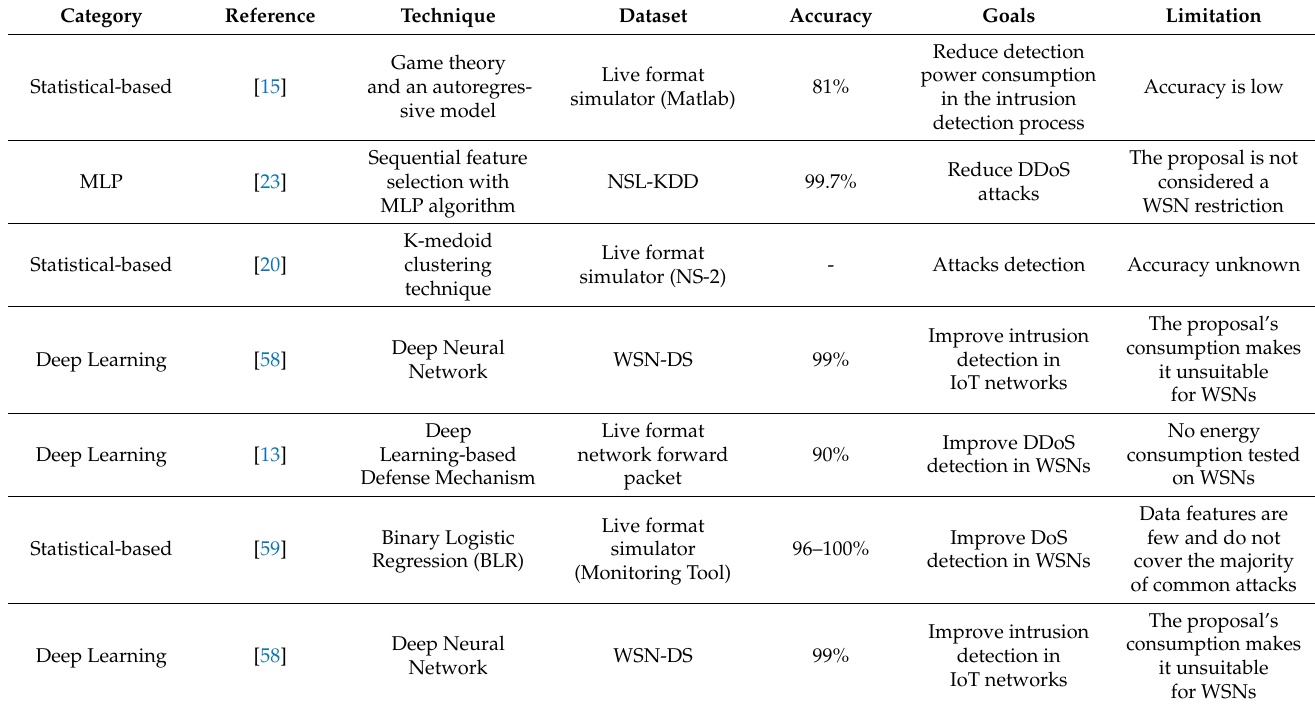
Table 2. Taxonomy of different machine learning algorithms in detection